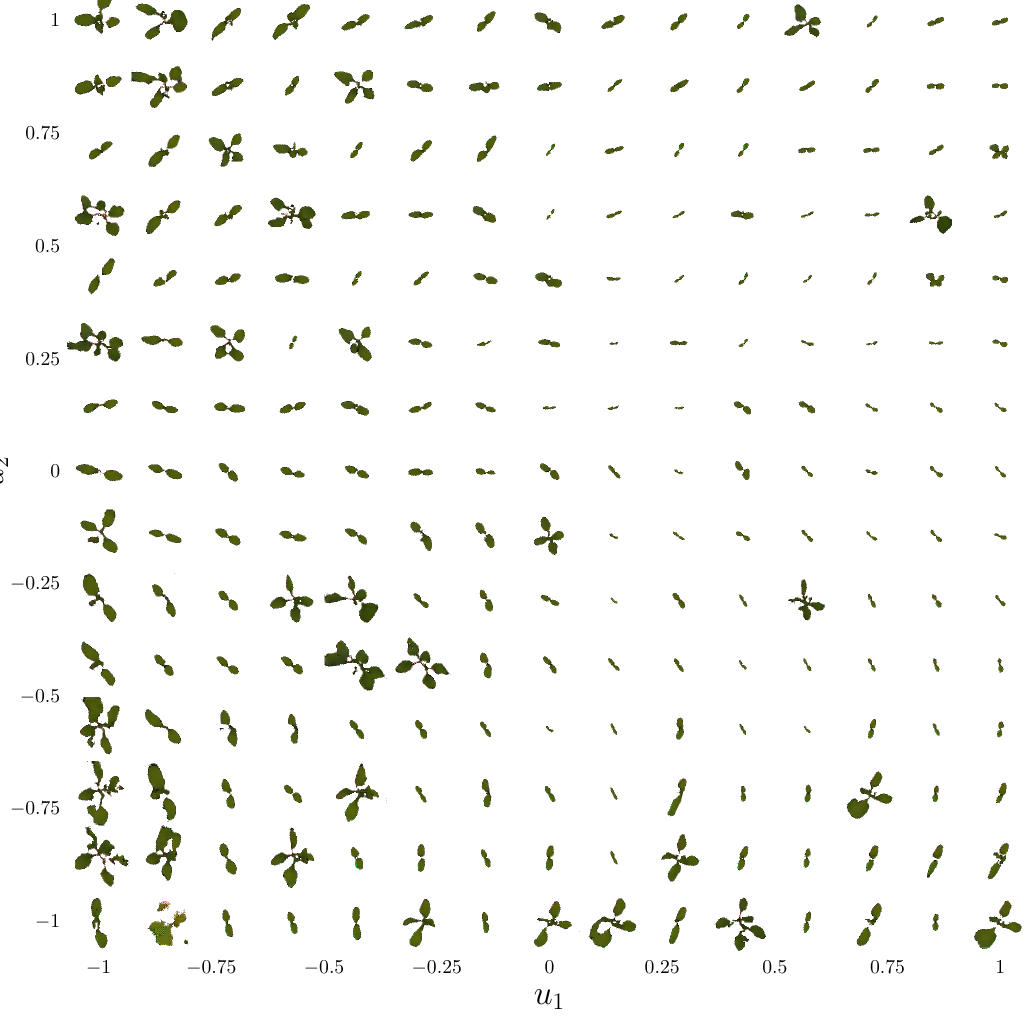
Figure 3. Visualization of the information space using two uniformly distributed continuous variables. The visualization shows that specific combinations of u 1 and u 2 can be used to control the rotation and size of the generated plant seedlings. All samples presented in the plot are supposed to represent